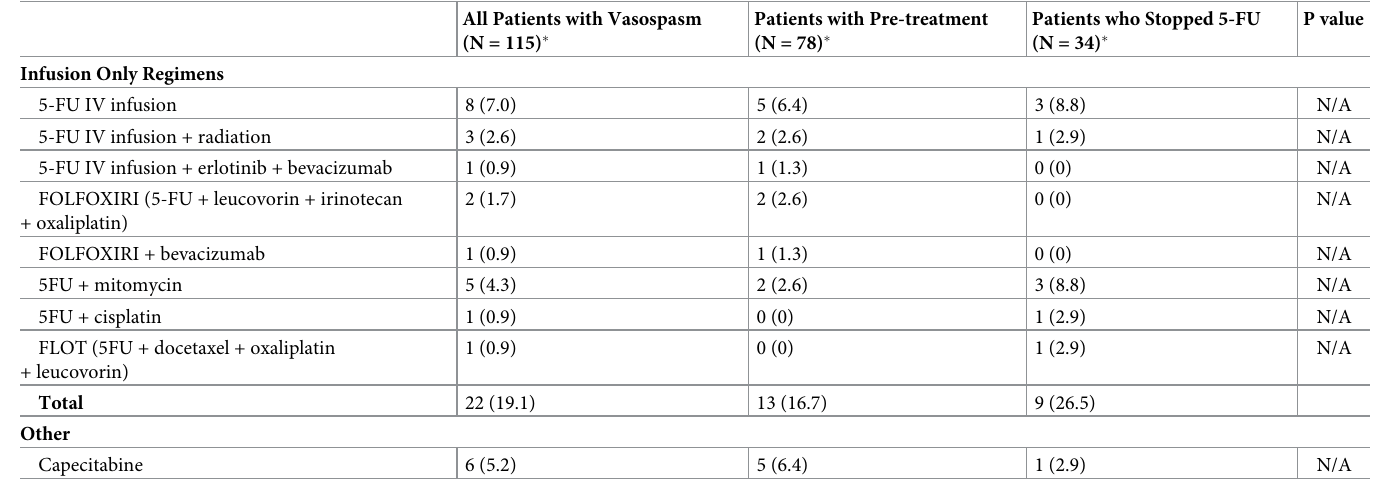
treatment (N = 78) and those who stopped 5-FU therapy (N = 34). Of note, P values were not generated when the sample sizes were too small to reflect meaningful differences between the groups, as in the case of different formulations of 5-FU therapy.